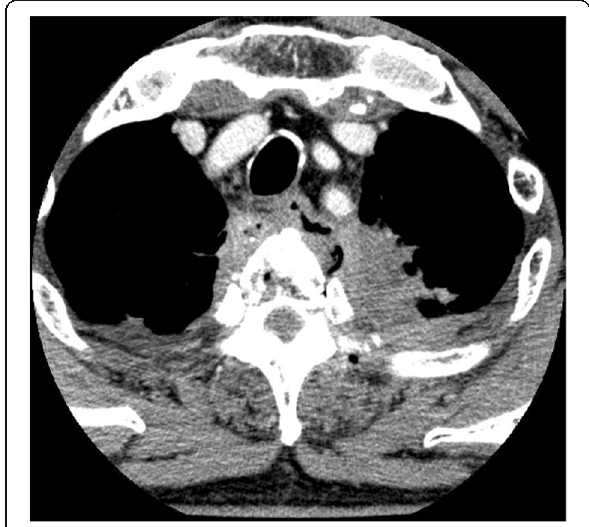
Fig. 2 Contrast-enhanced chest CT scan suggested the perforation of the esophagus in the upper left lateral wall with fluid and air in the posterior mediastinum. Osteolytic changes with free air space were observed within the vertebral